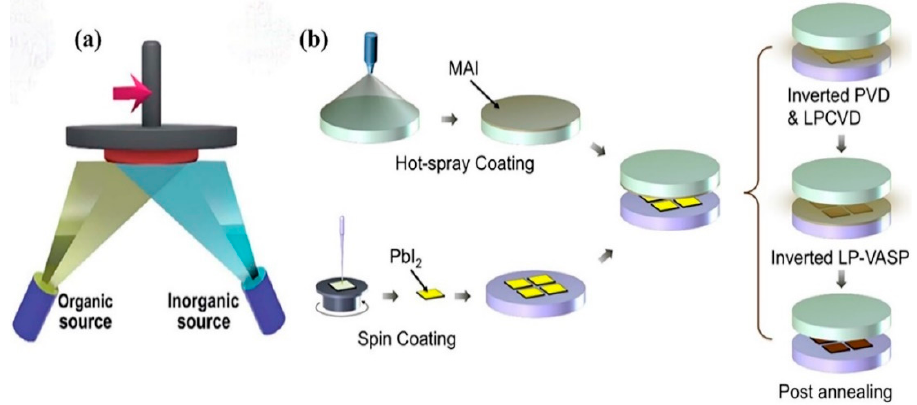
Figure 12. ( a ) Schematic diagram of double source co-evaporation [15]. Copyright 2018 Royal Soci- ety of Chemistry. ( b ) Schematic of vapor–solid reaction method [135]. Copyright 2016 Royal Society of Chemistry.